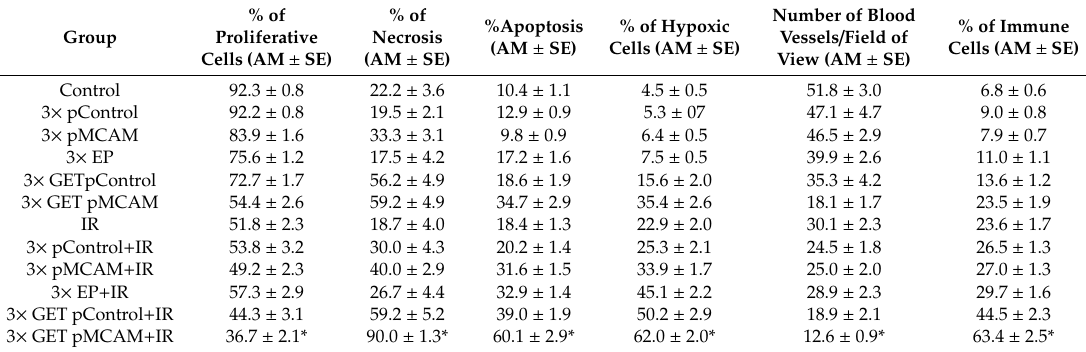
% of Immune Cells (AM ± SE)